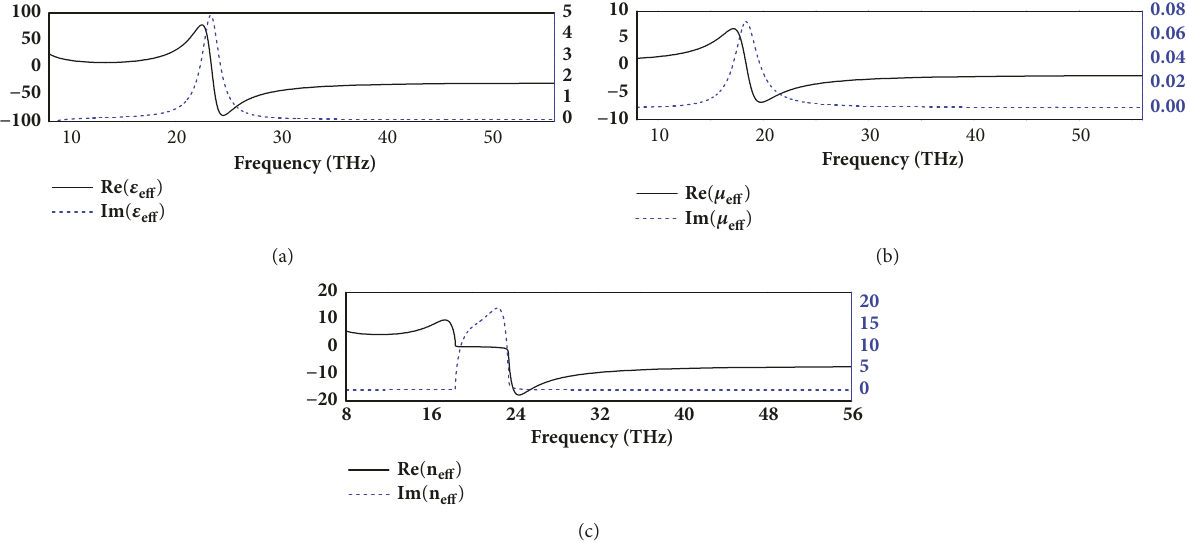
Figure 5: Calculated real and imaginary part of the complex permittivity, permeability, and refractive-index of the composite MMs in the terahertz region between 8 and 56 THz. Where 𝑟 = 1 um and 𝑇 = 350 K, the other parameters are same as in Figure 2.